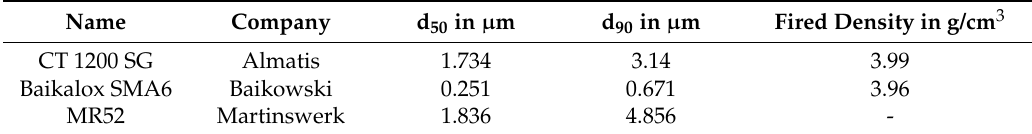
Table 1. Characteristics of the used alumina